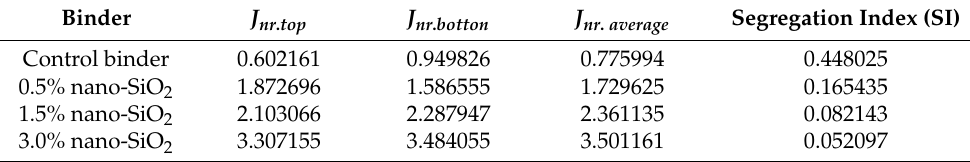
Table 5. Segregation index of TB rubberized asphalt with and without nano silica. Binder J nr . top J nr . botton J nr . average Segregation Index